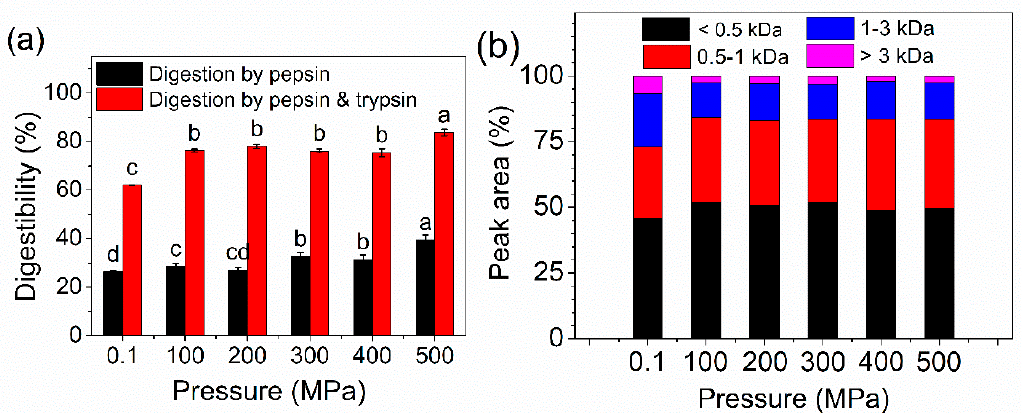
Figure 7. The digestibility ( a ) and the MW distribution of total digestive production ( b ) of control and HP-treated oyster proteins. Different lowercase letters indicate significant difference between groups ( p < 0.05).